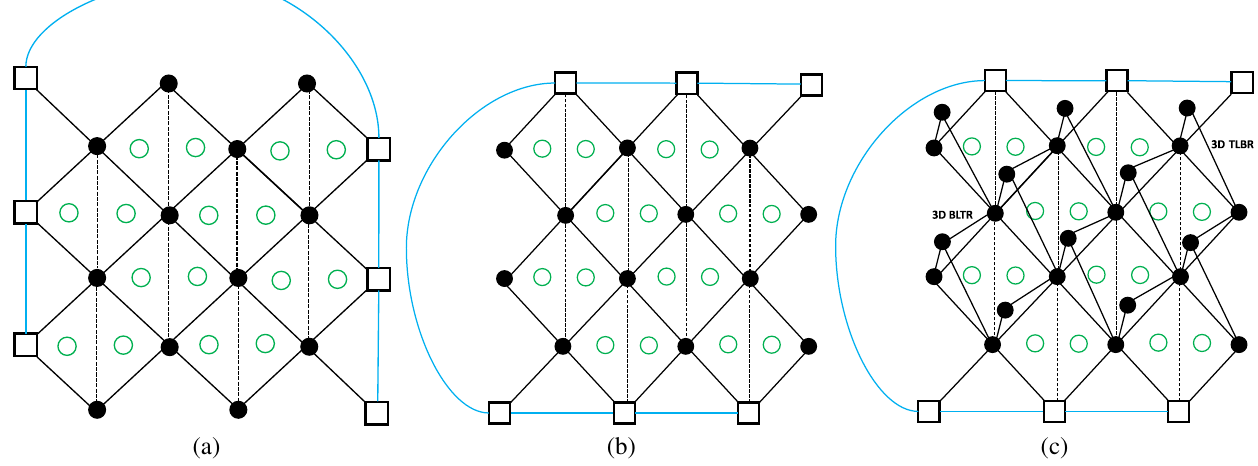
FIG. 8. Example of the graphs used to implement minimum-weight perfect matching for the d ¼ 5 heavy-square code for (a) Z -type- stabilizer measurements and (b) X -type-stabilizer measurements. The green vertices in (a) correspond to flag measurement outcomes during X -stabilizer measurements. Similarly, the green vertices in (b) correspond to flag measurement outcomes during Z -stabilizer measurements. In (c), we illustrate the graph associated with Z -stabilizer measurements with 3D diagonal and vertical edges connecting the two-dimensional graphs.